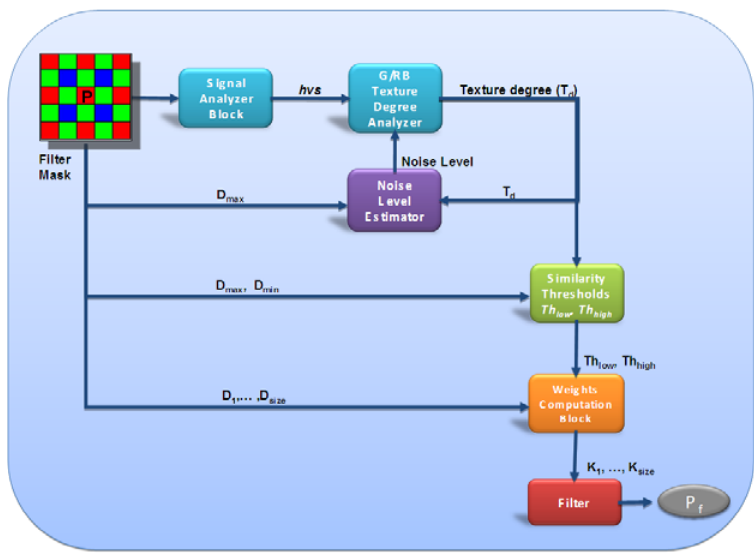
Figure 2. Overall Filter Block